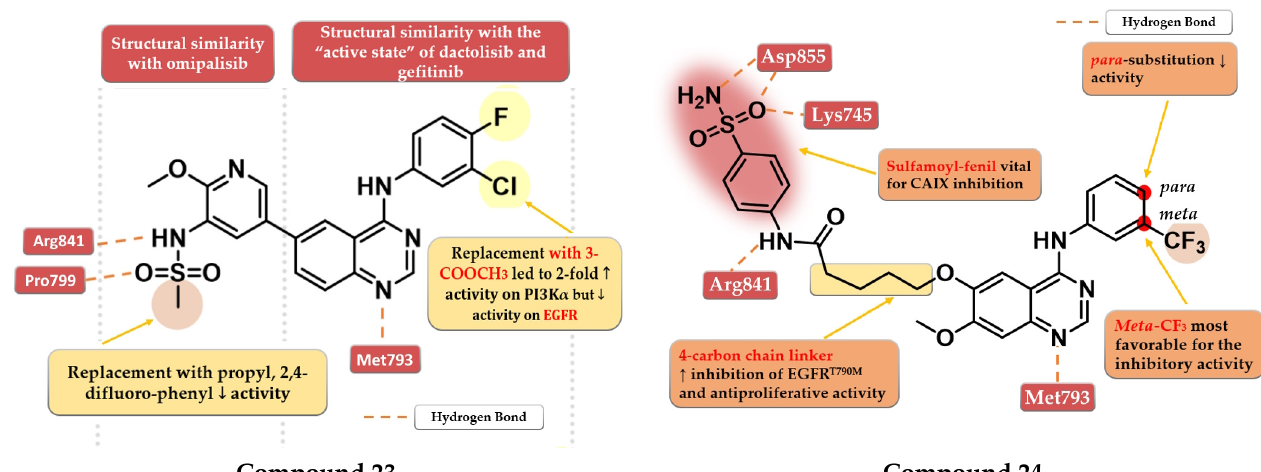
Figure 14. Structure–activity relationship and molecular docking of compound 23 in the human EGFR kinase domain (PDB ID 4WKQ) [131], as reported By Ding et al. [129]; structure–activity relationship and molecular docking of compound 24 in the human EGFR T790M kinase domain (PDB ID 2JIU) [115], as reported by Zang et al. [130].